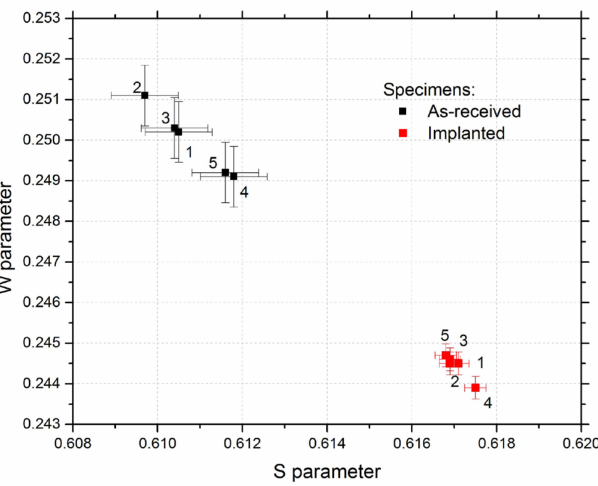
Figure 6. W parameter as a function of the S parameter for the as-received and proton-irradiated